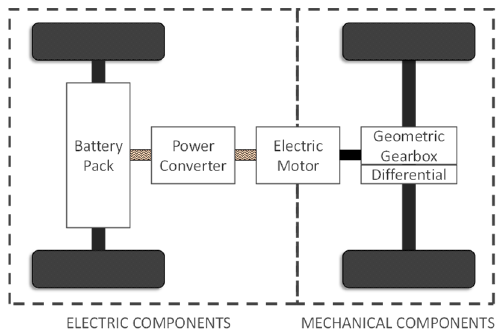
Figure 4. BEV SM-SA topology illustration.